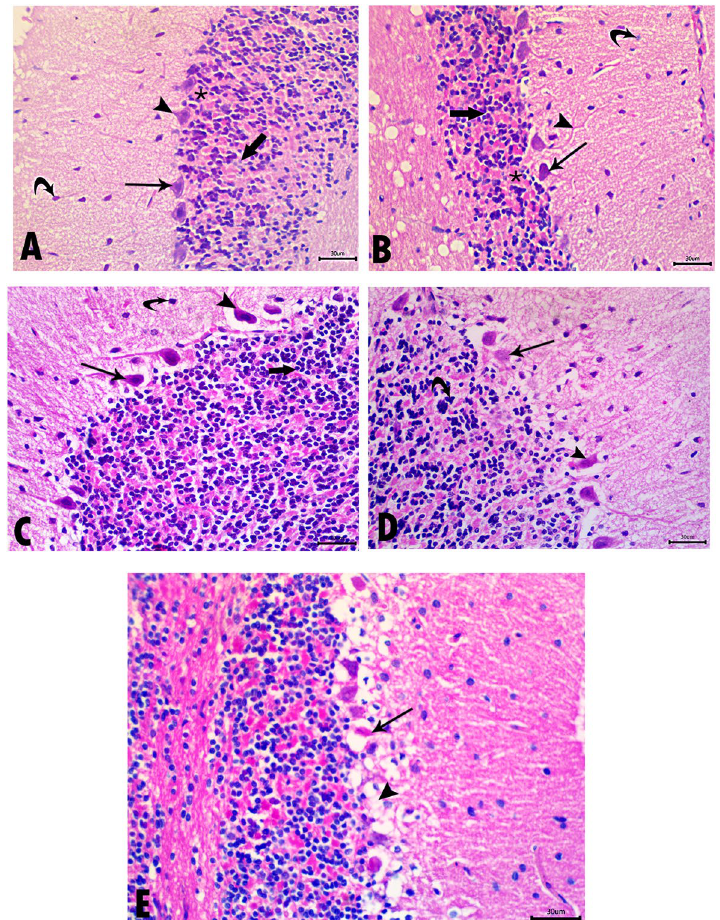
Fig. 3 Photomicrographs of sections in the cerebellar cortex stained with H&E ( 400). A and B Negative and positive control groups show the × three layers of the cerebellum. The outer molecular layer contains glial cells (curved arrows). The middle Purkinje cell layer has large, pyriform Purkinje neuronal cells with large central oval nuclei (arrows) and apparent cellular processes passing through the molecular layer (arrowheads). The inner granular layer shows an aggregation of small granule cells (thick arrows) separated by acidophilic areas (asterisk), representing the cerebellar glomeruli. C Acute treated group shows shrinkage of the Purkinje cell bodies with darkly stained nuclei and empty spaces surrounding them (arrowhead); others are distorted with small deeply stained nuclei (arrow). Some cells of molecular (curved arrow) and granular (thick arrow) layers appear with deeply stained nuclei. D Chronic treated group reveals marked degenerative changes in some Purkinje cells (arrow), and others are shrinkages leaving empty spaces surrounding them (arrowhead). Decreased packing of the nuclei in the granular layer is also detected. Some nuclei appear dense with irregular outlines (curved arrow). E Chronic withdrawal group shows degenerative changes in Purkinje cells (arrow), and some of them are lost, leaving empty spaces